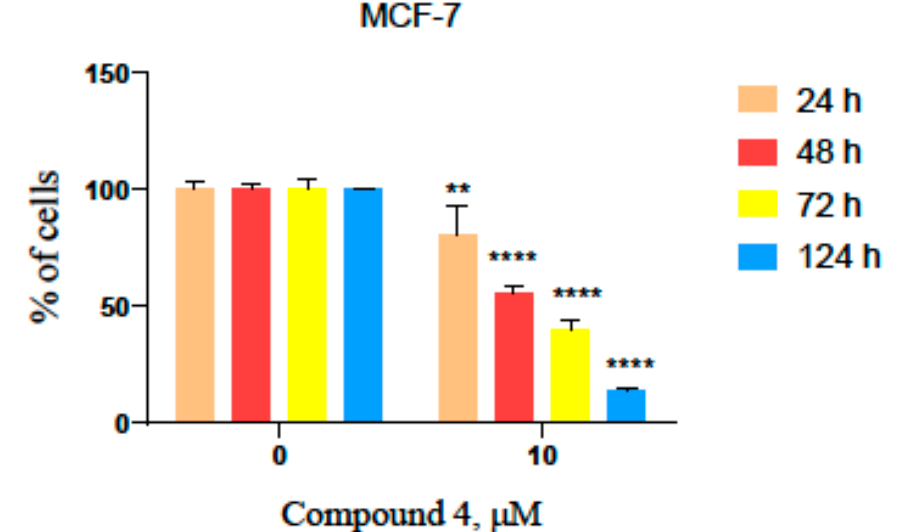
Figure 9. Time-dependent activity of 4 at concentration 10 µM after 24, 48, 72 and 124 h of treat- ment, MTT assay (** p < 0.01, **** p < 0.0001 compared with